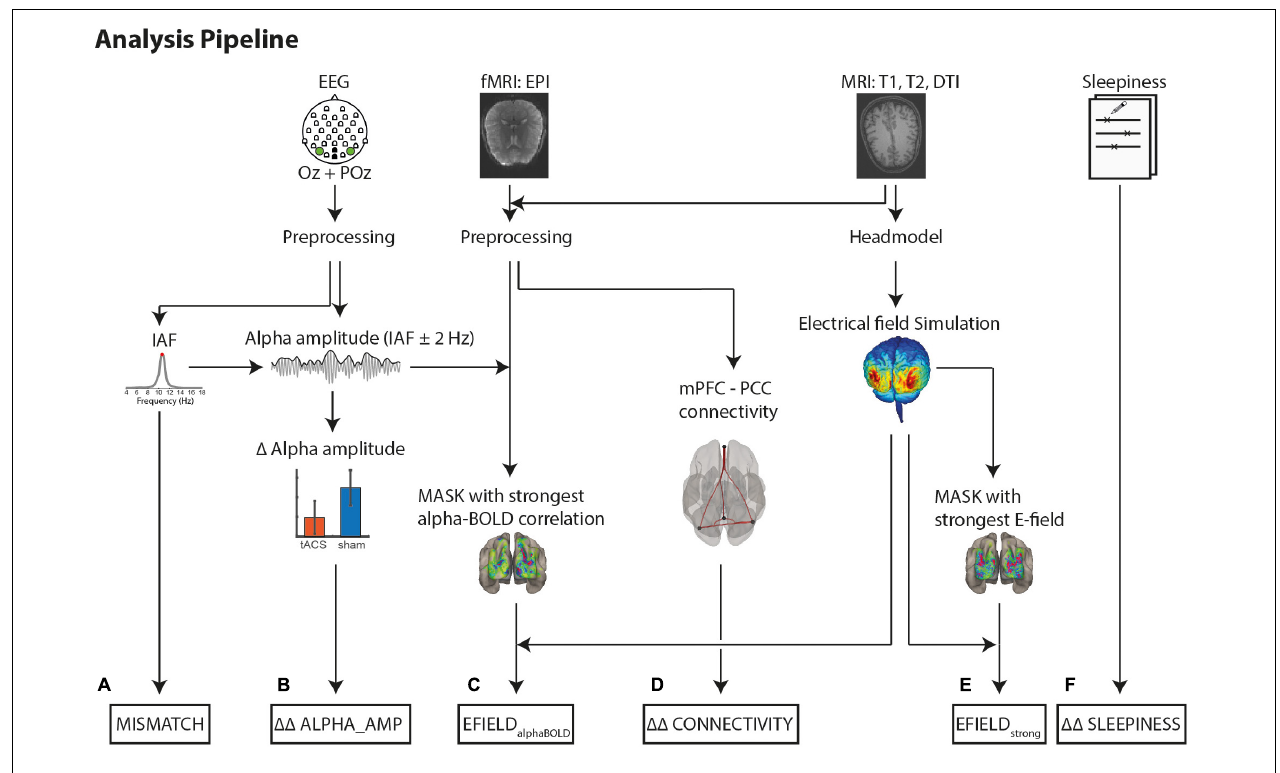
FIGURE 2 | Analysis pipeline to determine the variables for a multiple linear regression model. Dependent Variables: (B) Difference ( tACS - sham ) in alpha amplitude change ( post - pre ) ( (cid:49)(cid:49) ALPHA_AMP). Alpha amplitude was calculated as the mean envelope (absolute values of the complex Hilbert transform ± 2 Hz around IAF). (D) Differences ( tACS - sham ) in mPFC-PPC connectivity strength changes ( post - pre ) ( (cid:49)(cid:49) CONNECTIVITY). Covariate to control for intrinsic alpha modulators: (F) Differences ( tACS - sham ) of changes ( post - pre ) in self-rated sleepiness ( (cid:49)(cid:49) SLEEPINESS). Variables to explain tACS related